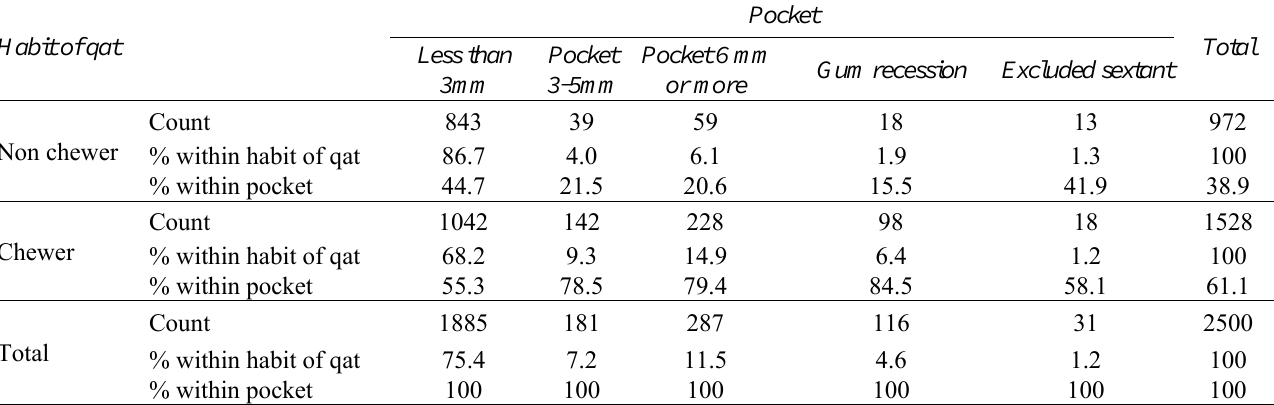
Table 1: Periodontal pockets and gum recession among Yemenis qat chewers and